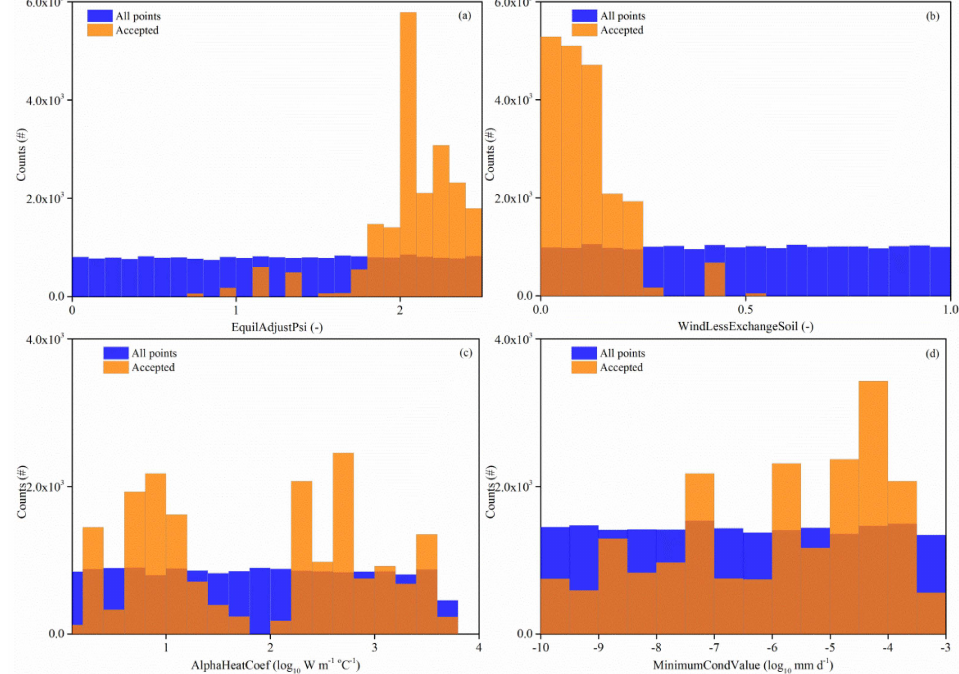
Figure 2. Posterior distributions of sensitive parameters. Blue for the prior distribution of parameters, and orange for the posterior distribution of